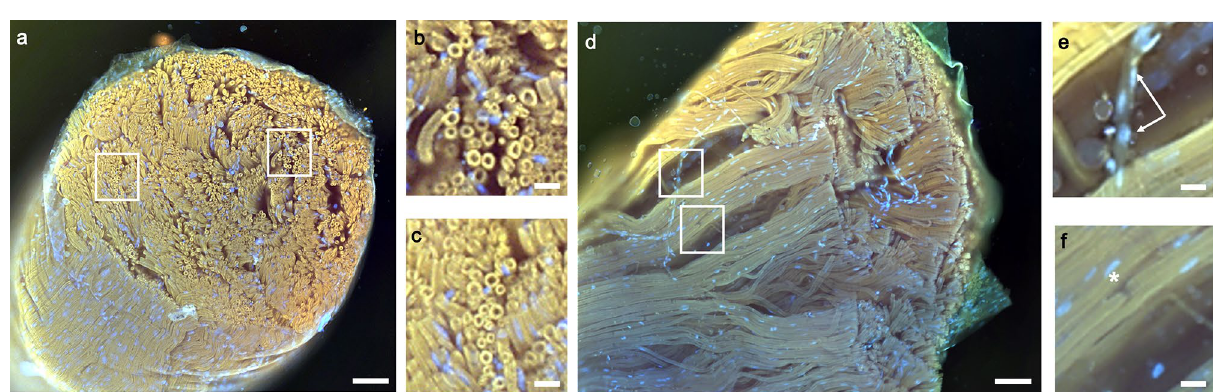
Figure 2. 2D-MUSE image of a rat sciatic nerve with staining. Sample was sectioned by hand with a razor blade, immersed in a rhodamine and Hoechst staining solution for 30 s, rinsed in DI water and imaged. ( a ) Transverse cross-section illustrates several myelinated fibers grouped as a single fascicle and surrounded by a thin perineural sheath. ( b and c ) Close up views from ( a ) show multiple myelinated fibers as yellow rings. ( d ) Longitudinal cross section allows visualizing fibers along the length of the nerve. ( e ) Zoomed in region from ( d ) illustrates microvasculature revealed by Hoechst staining and evident from tubular structure (arrows). ( f ) A gap in the myelinated fibers is visible in this close-up view, suggestive of Schimdt-Lanterman clefts or node of Ranvier (asterisk). Scale bars are: 100 µm ( a , d ) and 20 µm ( b , c , e , f Since the volume was sectioned at 5 µm thickness, variations in the shape of structures from one slice to the next were low, allowing determination of structure continuity. Such vascular networks supply nutrients to regions distant from the nerve cell body. When the sub-volume was visualized from the side (XZ plane, longitudinal view), we identify multiple myelinated axons (Supplementary Movie 1). Upon stepping through individual slices in this view, we identify that the full length of the axons is not visible in a single slice but extends over multiple slices. This indicates that axon morphology is not perfectly described by a cylinder and necessitates a more com- plex 3D description. Volumetric imaging revealed a fascicle merging event (Supplementary Movie 2). The two fascicles are initially seen close to one another and are separated by a perineural sheath. As we move deeper into the nerve, we identify that the sheath gets progressively thinner, until there is merging.